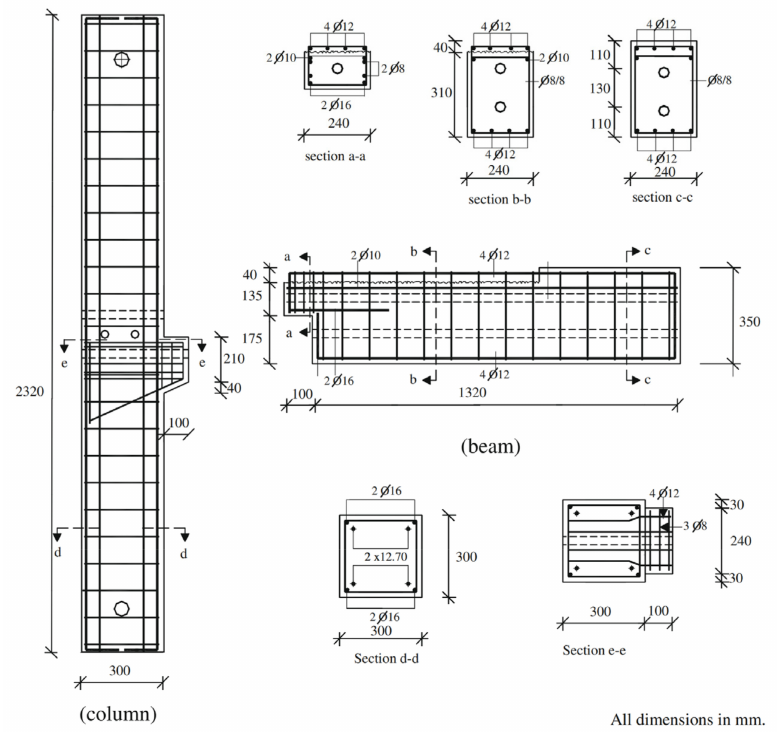
Figure 5. Size and reinforcement of the specimens from [27] used for model validation. Pan et al. [28] conducted cyclic loading tests on dry-connected assembled joints with floor slabs in 2018, comparing their hysteretic performance, stiffness, loadbearing capacity and energy dissipation capacity with cast-in-place joints. In the experimental program, four fabricated joint specimens were designed, mid-joint A2 (unbonded inside the column), mid-joint A3 (unbonded outside the column), edge-joint B2 (unbonded inside the column) and edge-joint B3 (unbonded outside the column). Two comparative cast-in-situ specimens were also designed, namely mid-joint A1 and edge-joint B1. Figure 6 shows the cross sections of the specimen. The loading mode of that experiment consisted of a single cycle for the story drift ratio 1/2000 and three cycles for the additional stages of the loading protocol corresponding to 1/1000, 1/800, 1/550, 1/400, 1/300, 1/200, 1/100, 1/67, 1/50, 1/40, 1/30, 1/25, 1/20 and